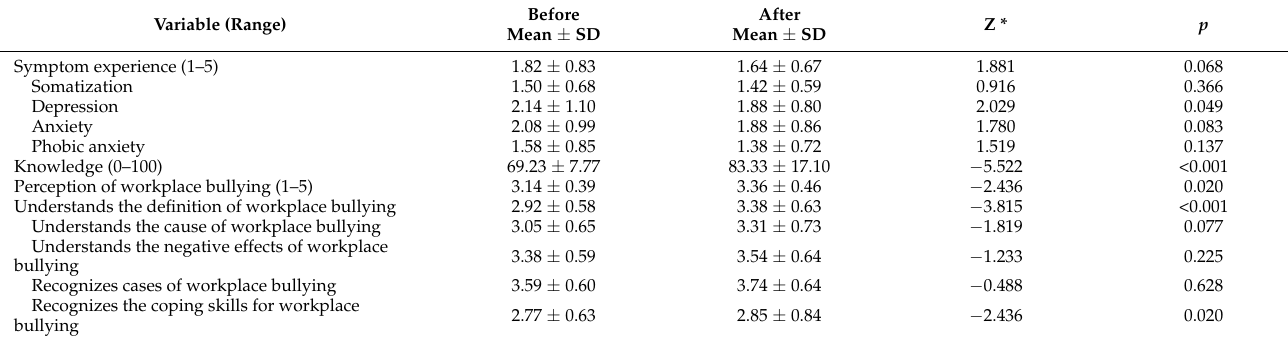
Table 4. Comparing symptoms, knowledge, and perceptions of workplace bullying before and after the program ( N =